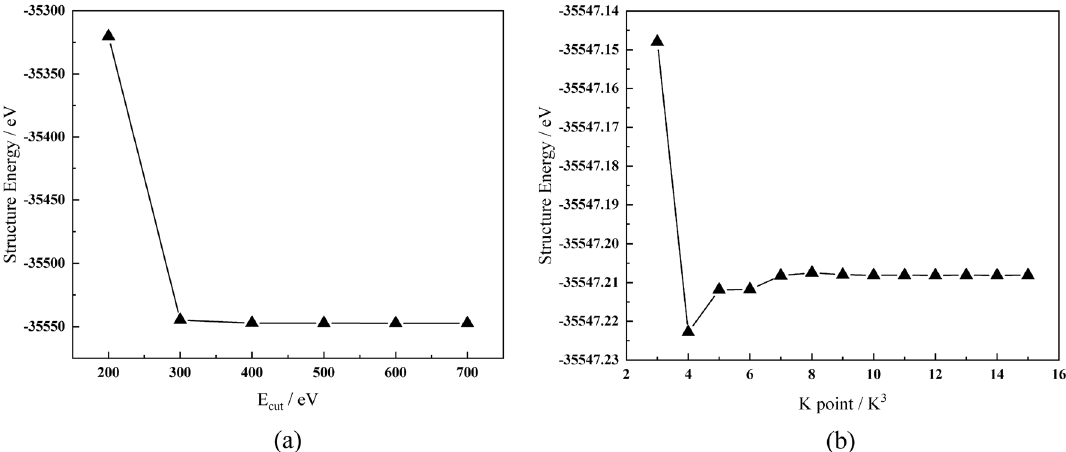
Figure 2. Convergence tests of the parameters: ( a ) Energy cut-off (E cut ) ( b ) K Point.